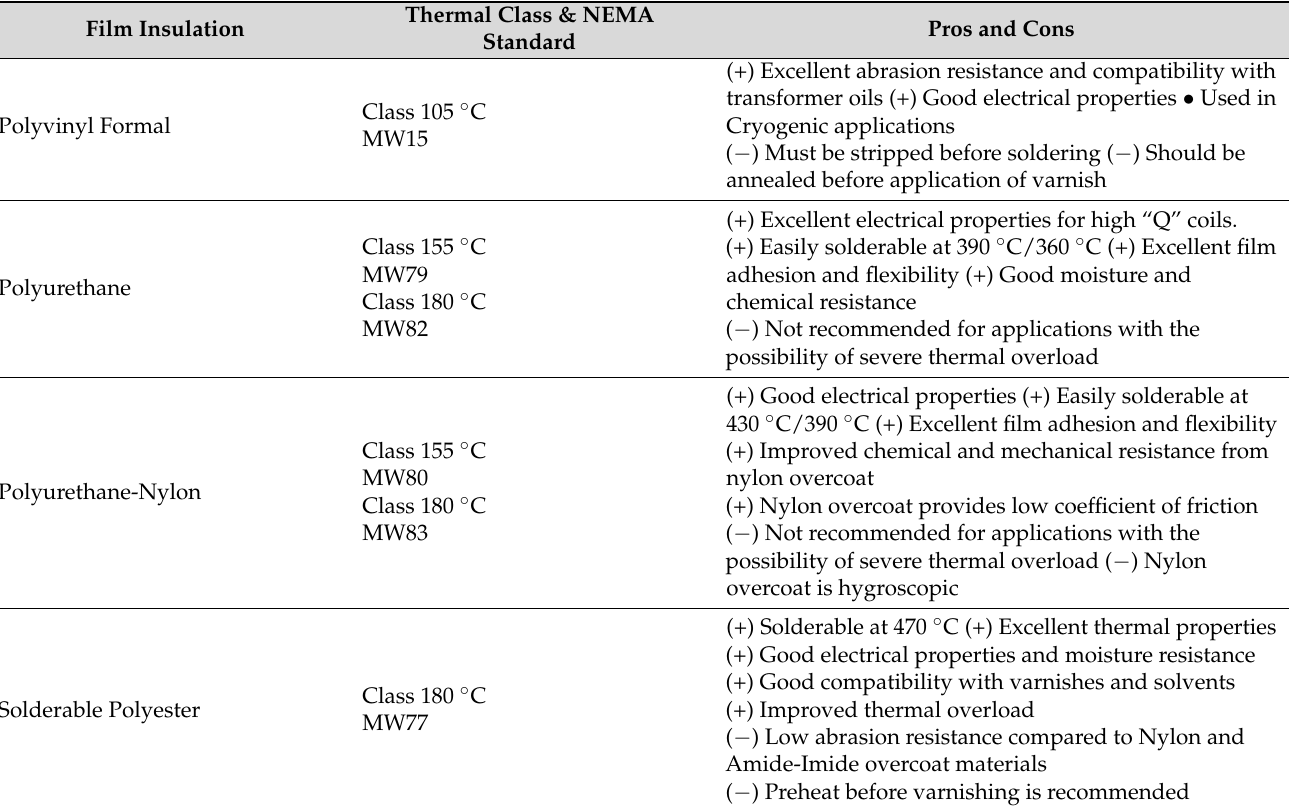
Table A1. Classification of film insulation based on their thermal class [56]. Film